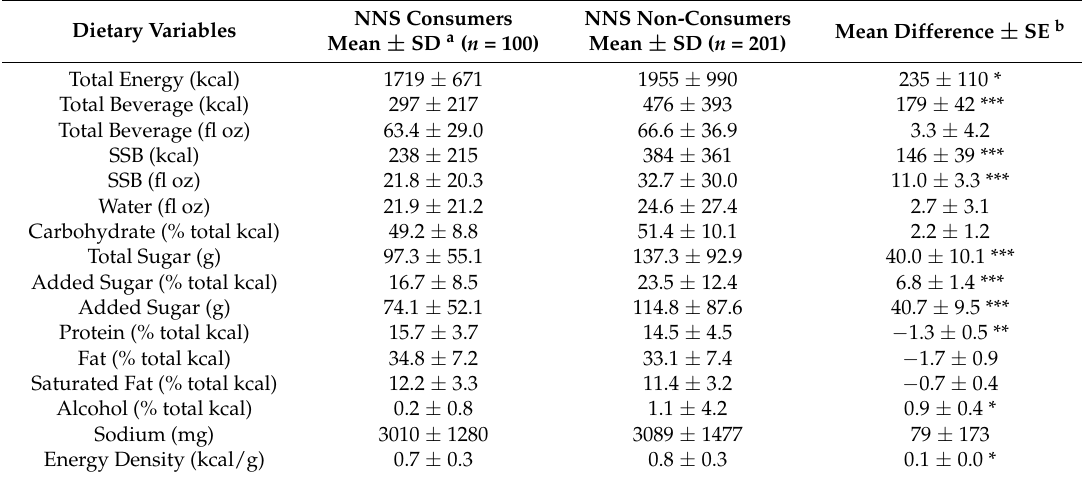
Table 5. Dietary factors for non-nutritive sweetener (NNS) consumers versus NNS